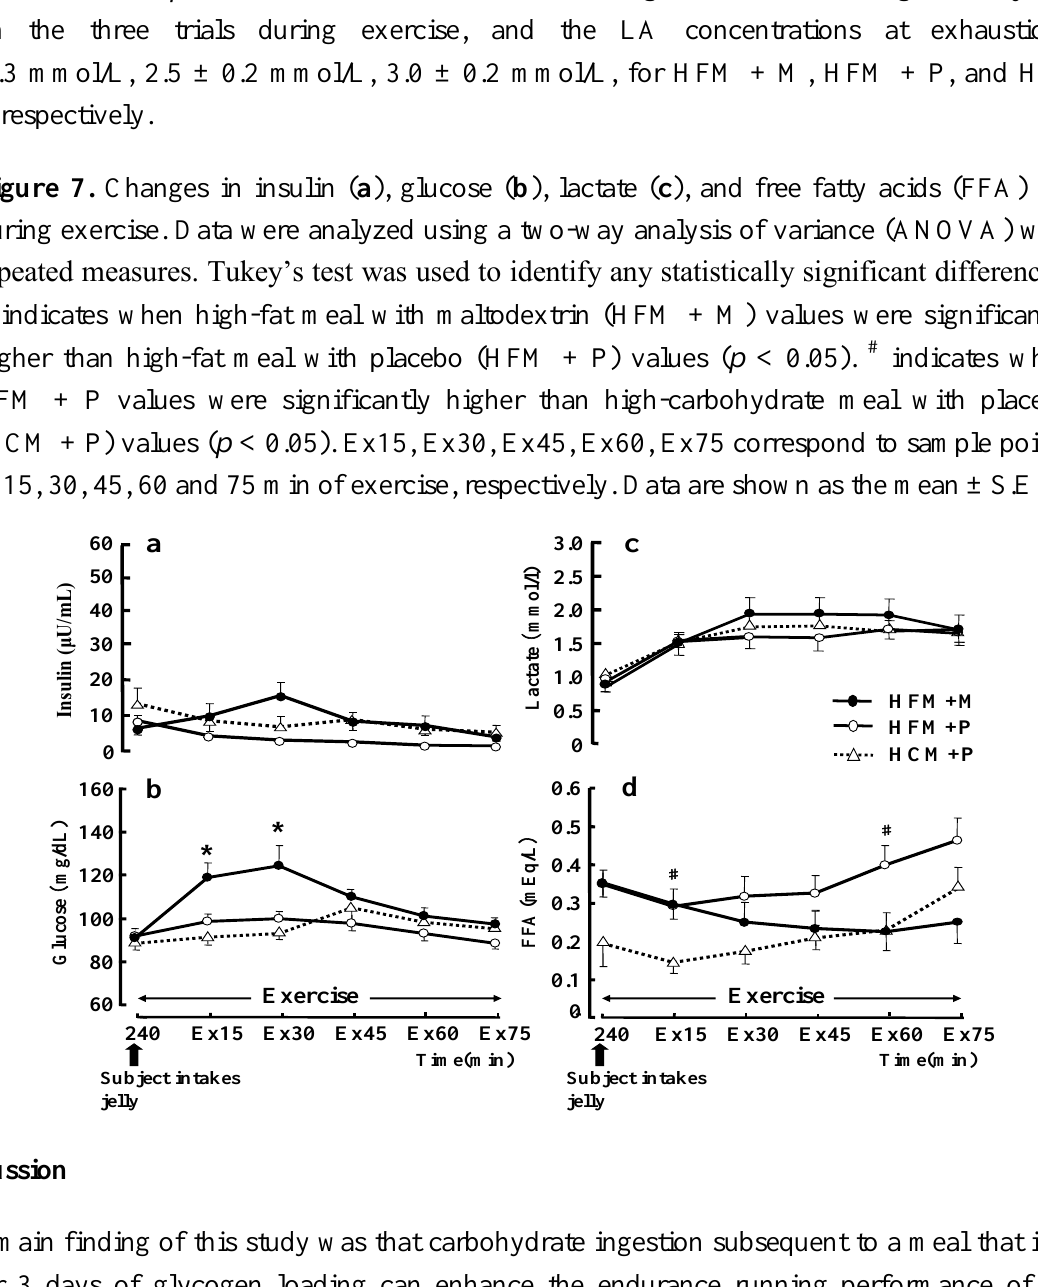
Figure 7. Changes in insulin ( a ), glucose ( b ), lactate ( c ), and free fatty acids (FFA) ( d ) during exercise. Data were analyzed using a two-way analysis of variance (ANOVA)